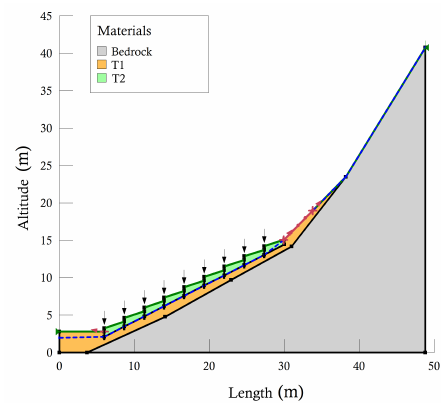
Figure 11. Model used to simulate, on slope S2, the presence of stockade.